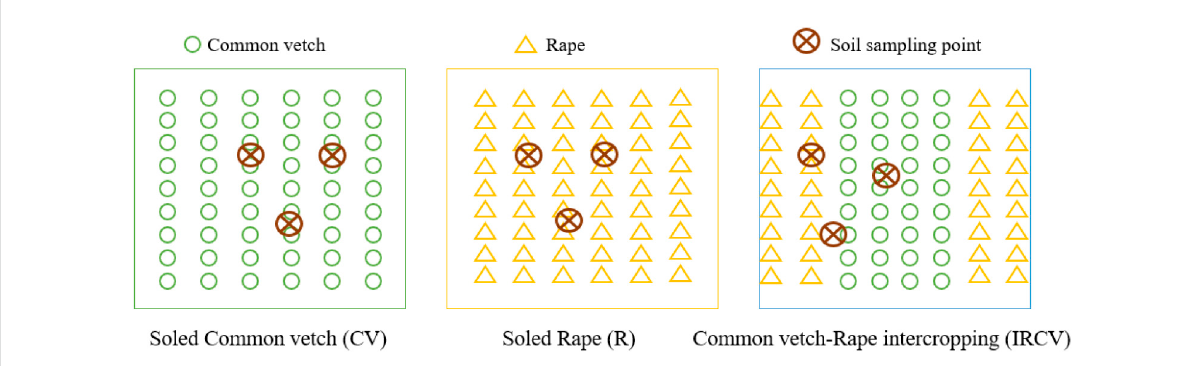
FIGURE 1 Schematic diagram of the planting pattern and soil sampling. CV, R, and IRCV represent common vetch monoculture, rape monoculture, and two rows of rape alternated with four rows of common vetch,